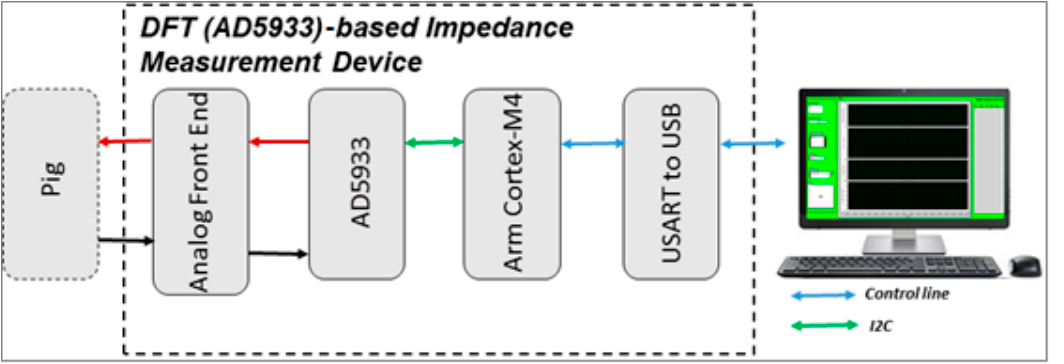
Figure 1. Block diagram of the developed AD5933-based impedance measurement system.